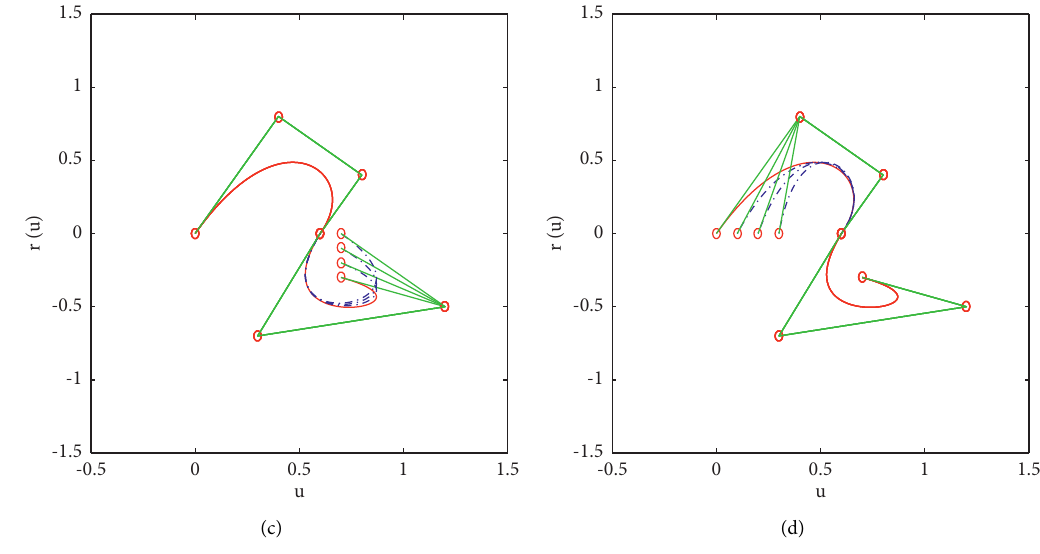
Figure 3: Effect of control points on open curve